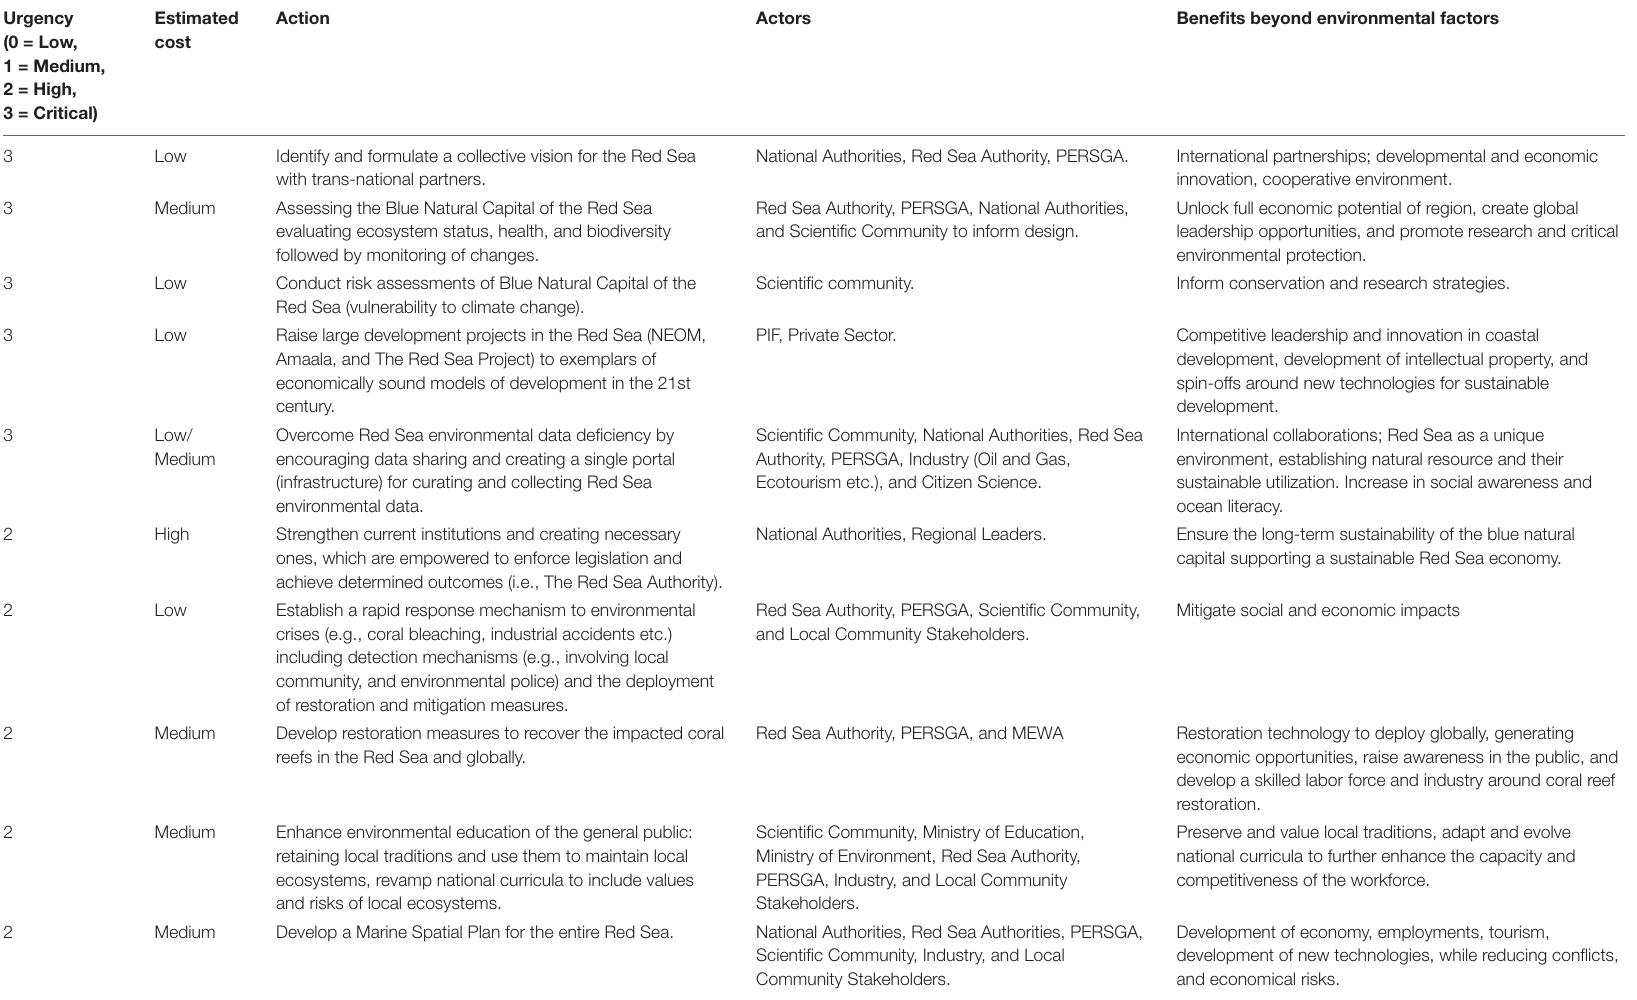
TABLE 1 | A suggested action plan on how to ensure the sustainable development and preservation of blue natural capital in the Red Sea region. Urgency (0 =